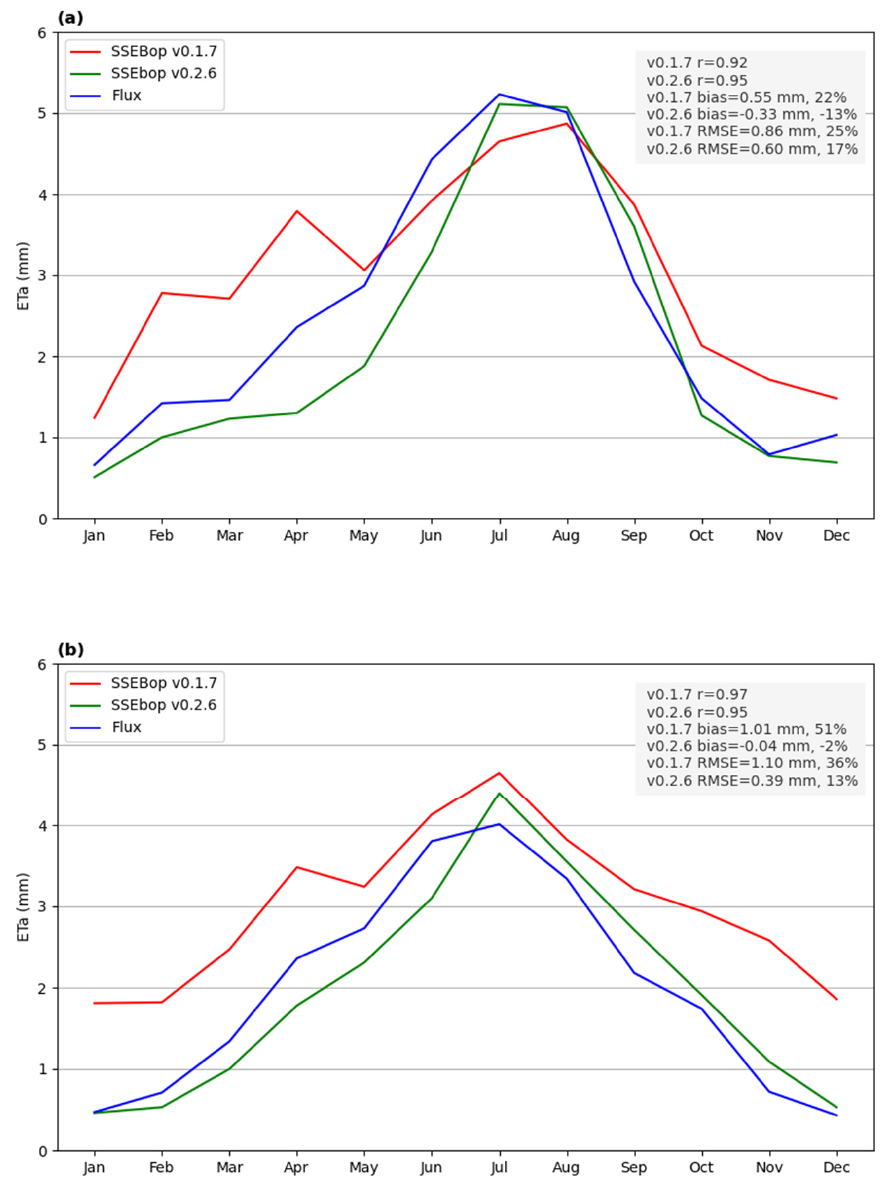
Figure 9. Monthly averages of ETa observations from tower sites for the EC ETa (Flux, blue), SSEBop ETa v0.1.7 (red) and SSEBop ETa v0.2.6 (green) including r, bias and RMSE statistics. ( a ) monthly averages for all cropland sites ( n = 8); ( b ) monthly averages for all grassland sites ( n = 6).